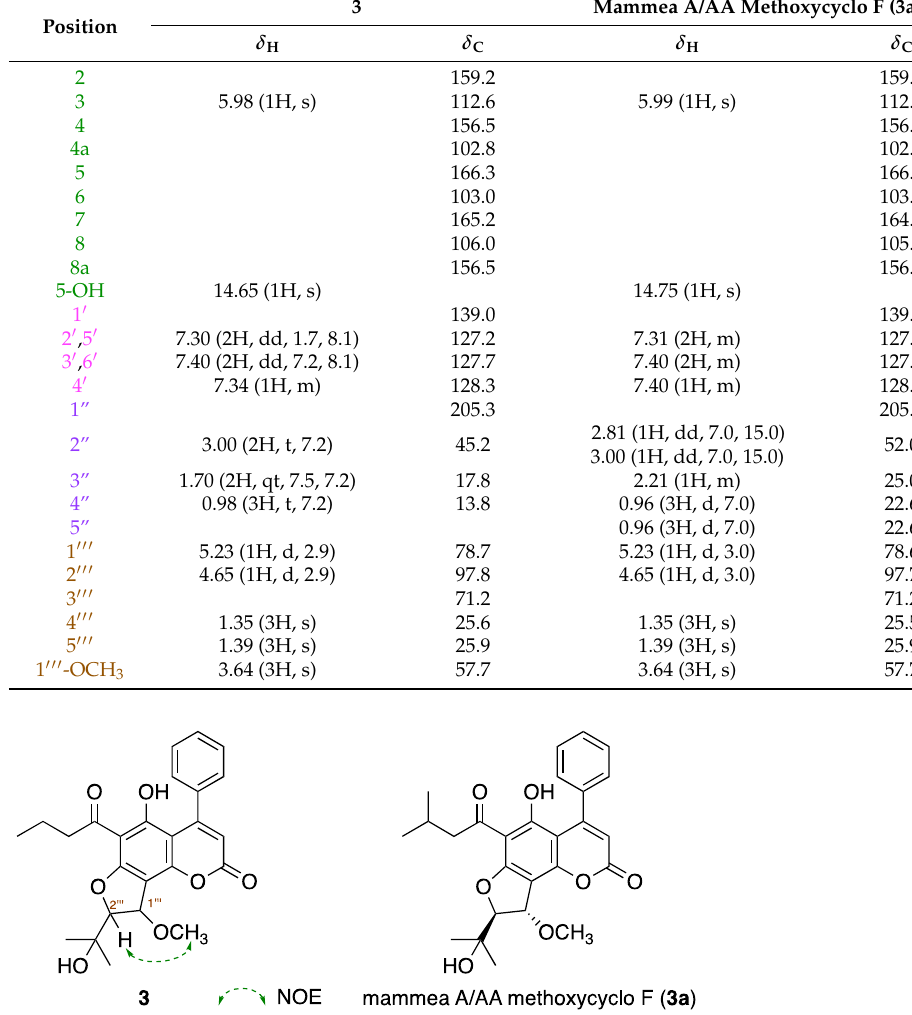
Figure 3. Coupling constant 3 J 1 ′′′ ,2 ′′′ value and difference NOE correlation of 3 . Reported value (CDCl 3 ) of mammea A/AA methoxycyclo F ( 3a ).